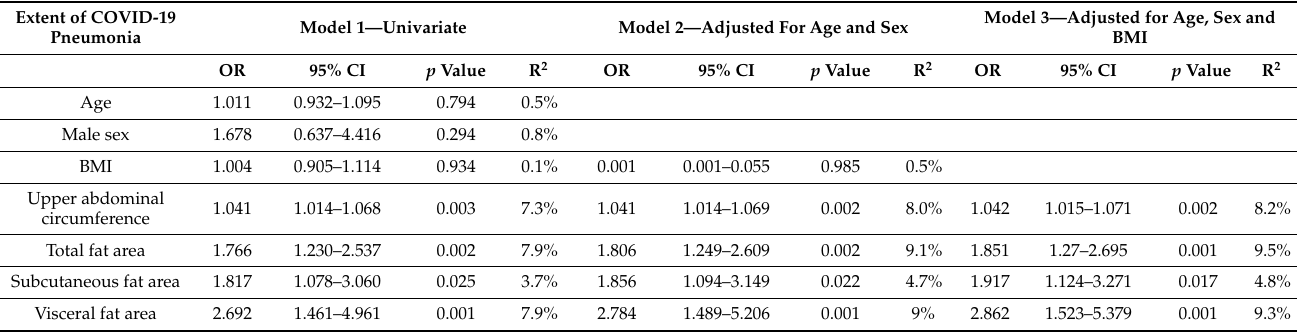
Table 2. Univariate and multiple ordered logistic regression models for the association with the extent of COVID-19 pneumonia. Extent of COVID-19 Pneumonia Model 1—Univariate Model 2—Adjusted For Age and